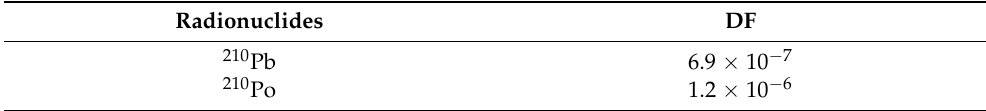
Table 1. Dose coefficient (DF) for ingestion dose